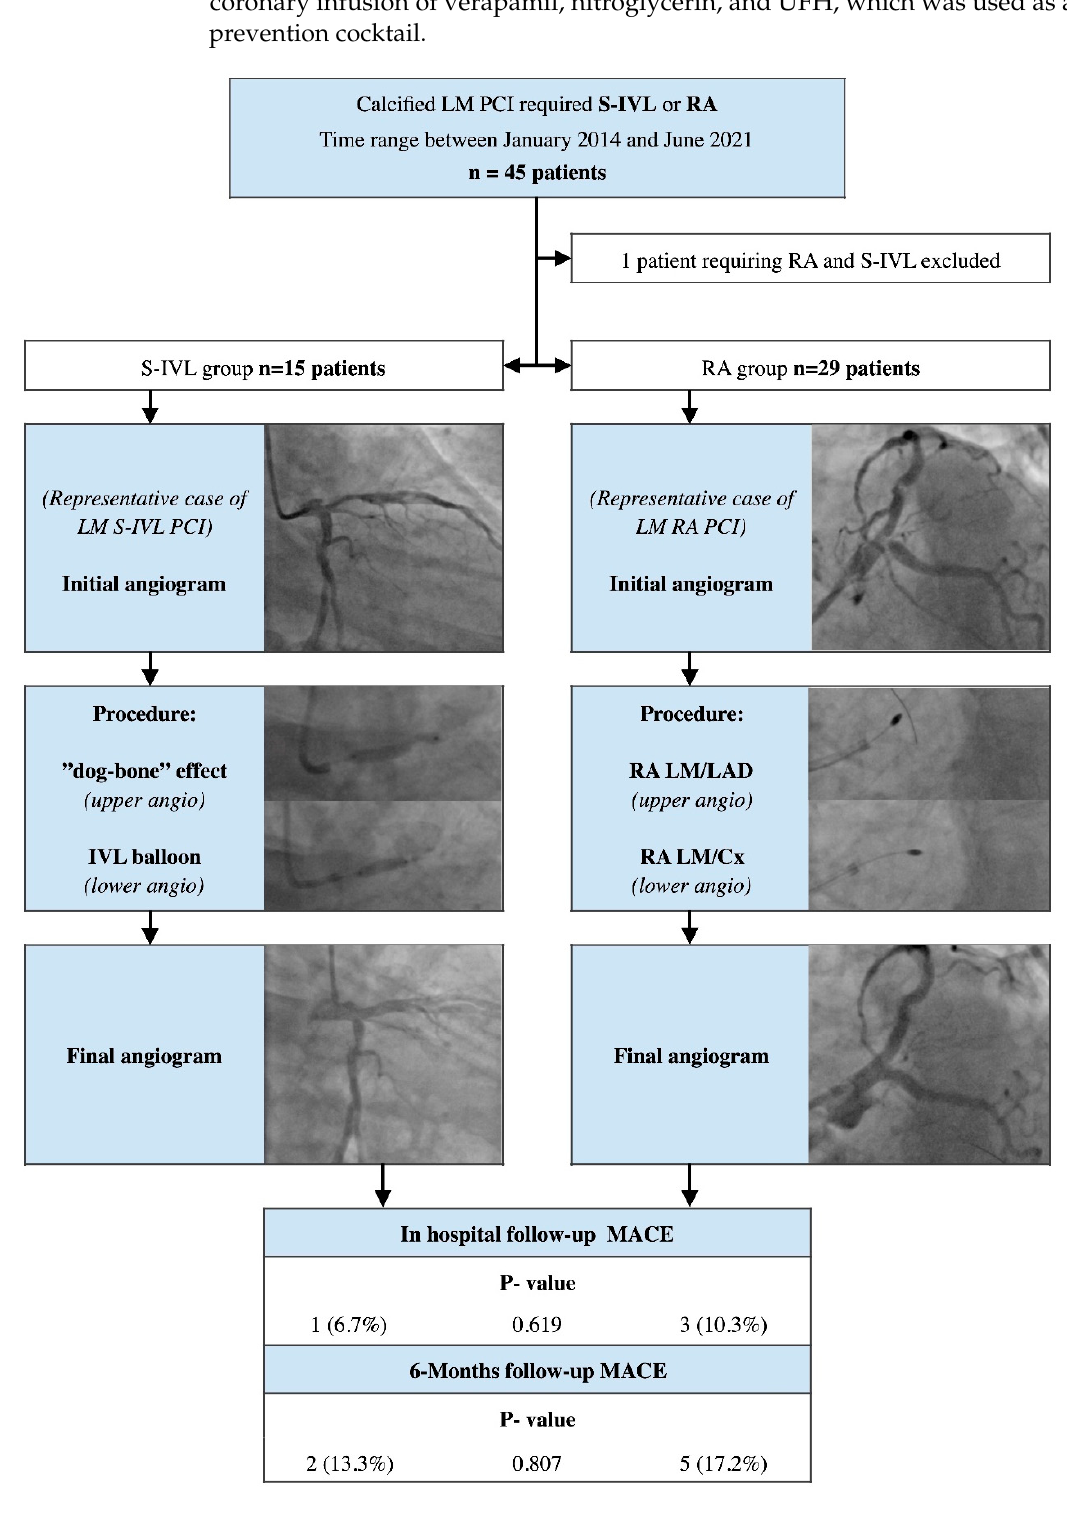
Figure 1. A flow chart of the study protocol with inclusion and exclusion criteria. Abbreviations: LM—Left Main; PCI—percutaneous coronary intervention; S-IV—Shock Wave Intravascular Lithotripsy; RA—Rotational Atherectomy; LAD—Left Anterior Descending artery; Cx—Circumflex artery; MACE—major adverse cardiac events.